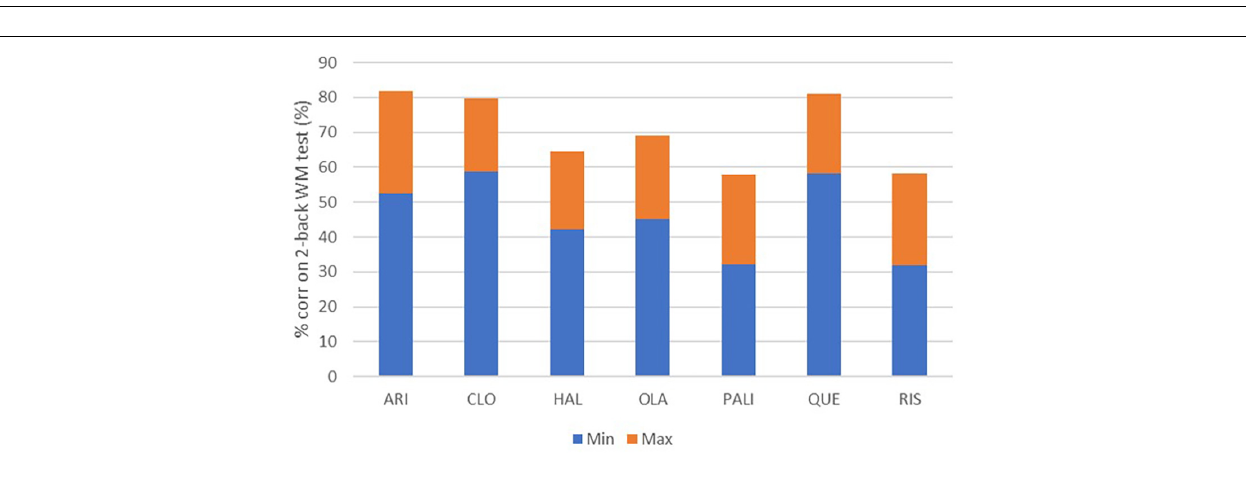
one genotype), olanzapine (3), haloperidol (2), and